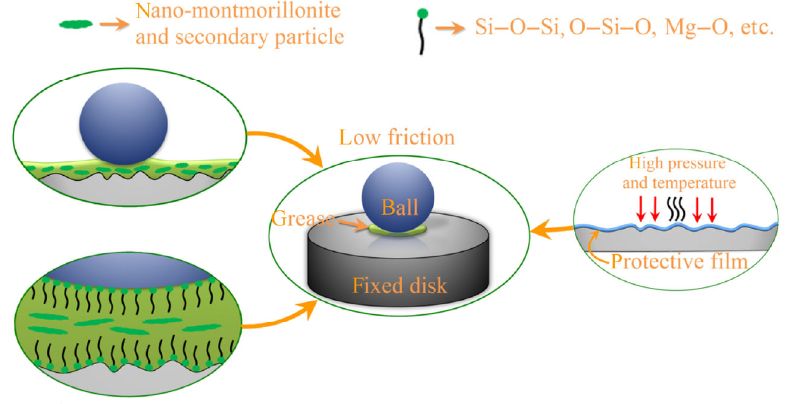
Fig. 11 Schematic of friction mechanism of the insulating